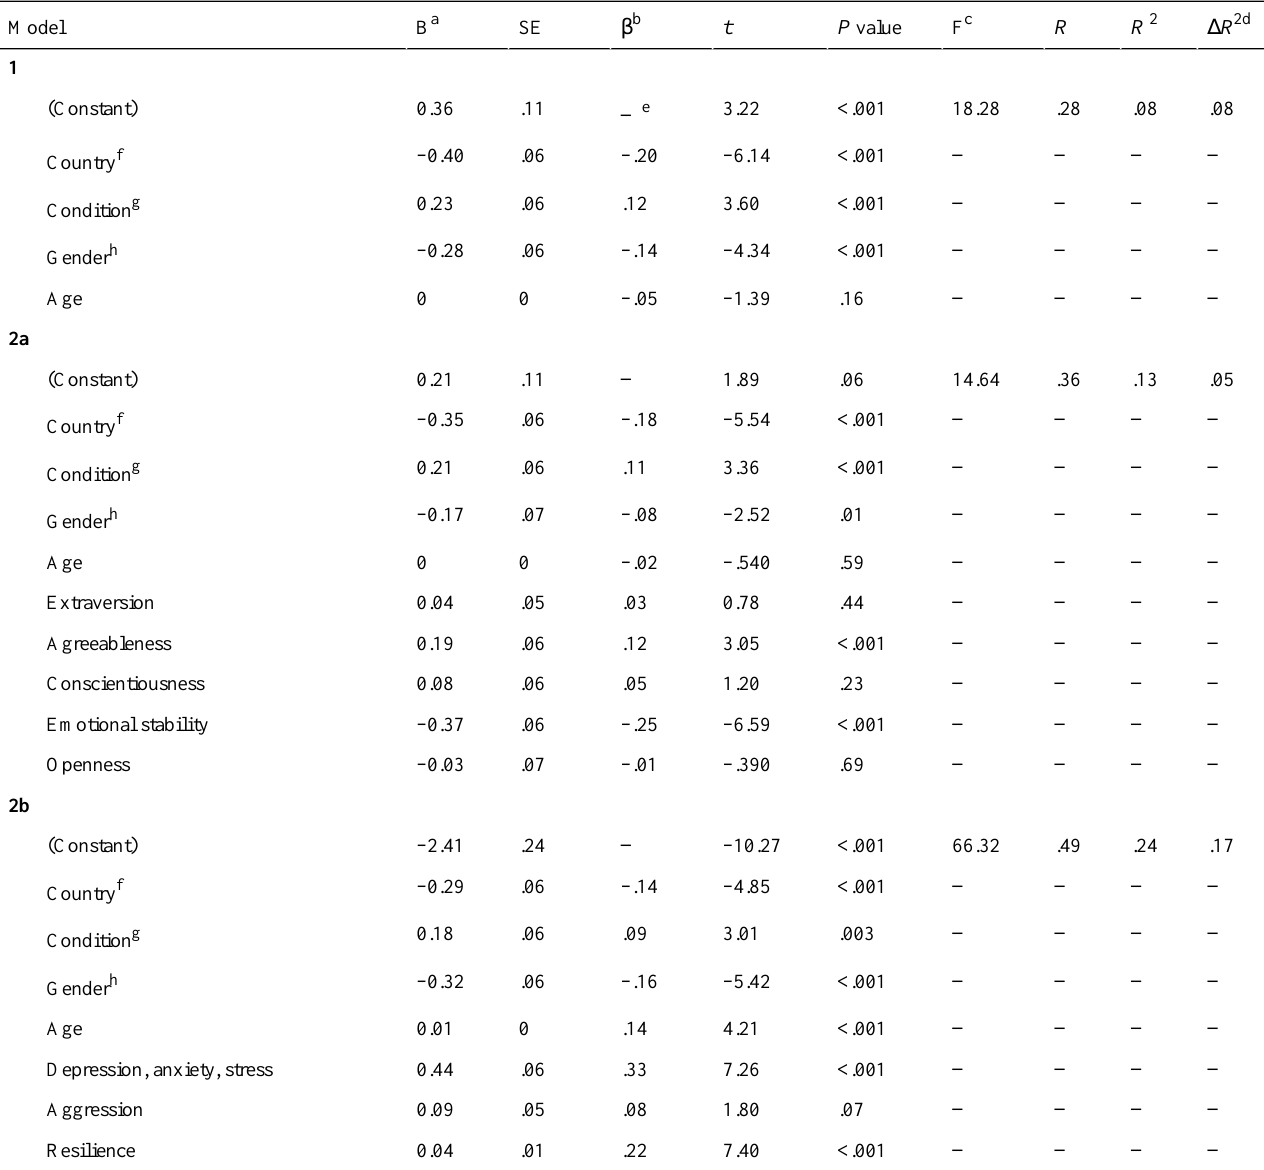
Table 3. Results of hierarchical regression analyses showing amount of variance in the emotional intensity dimension accounted for by country of residence, condition, gender, age, Big Five personality traits, DASS-21, aggression, and